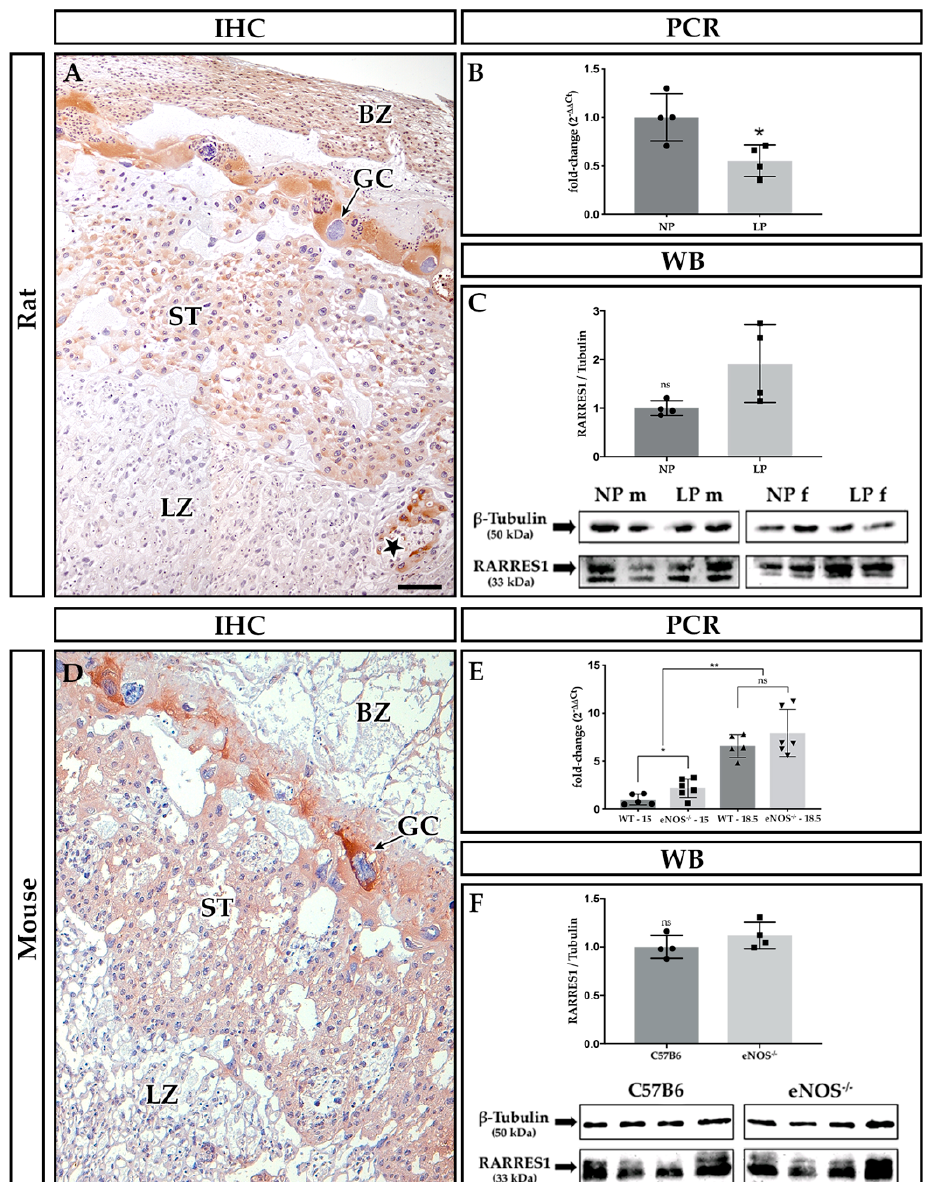
Figure 1. Rarres1 expression in rat and mouse placenta. ( A − C ) Rat placenta, ( D − F ) mouse placenta. ( A , D ) Immunohistochemical (IHC) stains of methyl Carnoy-fixed placental paraffin sections. Abbreviations: GC = giant cell, BZ = basal zone, ST = spongiotrophoblast, LZ = labyrinth zone, star = glycogen cells. The bar equals 100 µm. ( B ) Maternal protein restriction rat model: placental Rarres1 mRNA expression on E18.5 (* p = 0.03, Mann-Whitney U -Test, n = 4 NP/LP dams with 6 pups each). E) eNOS -/- mouse model: placental Rarres1 mRNA expression on E15 and E18.5 (* p = 0.03, ** p = 0.008 for C57BL/6 and p = 0.002 for eNOS -/- , ns: p = 0.66, Mann-Whitney U -Test, WT: n = 5 dams, eNOS -/- : n = 6 dams with 2 pups each). C + F) Analysis of Rarres1 protein expression versus β -Tubulin housekeeper by Western blotting (WB, Rat: ns: p = 0.057, Mann-Whitney U -Test, n = 4 NP/LP dams with n = 2 pups each, E18.5; Mouse: ns: p = 0.20, Mann-Whitney U -Test, n = 4 C57B6 and eNOS -/- dams per group with n = 1 pup each, E18.5). Abbreviations: LP = low protein diet, NP = normal protein diet in the rat IUGR model with m = male fetus, f = female fetus; C57B6 = C57BL/6 wild type (WT) control strain, eNOS -/- = preeclampsia (PE)/intrauterine growth restriction (IUGR) model eNOS knockout mouse, ns = not significant. RARRES = retinoic acid receptor responders.